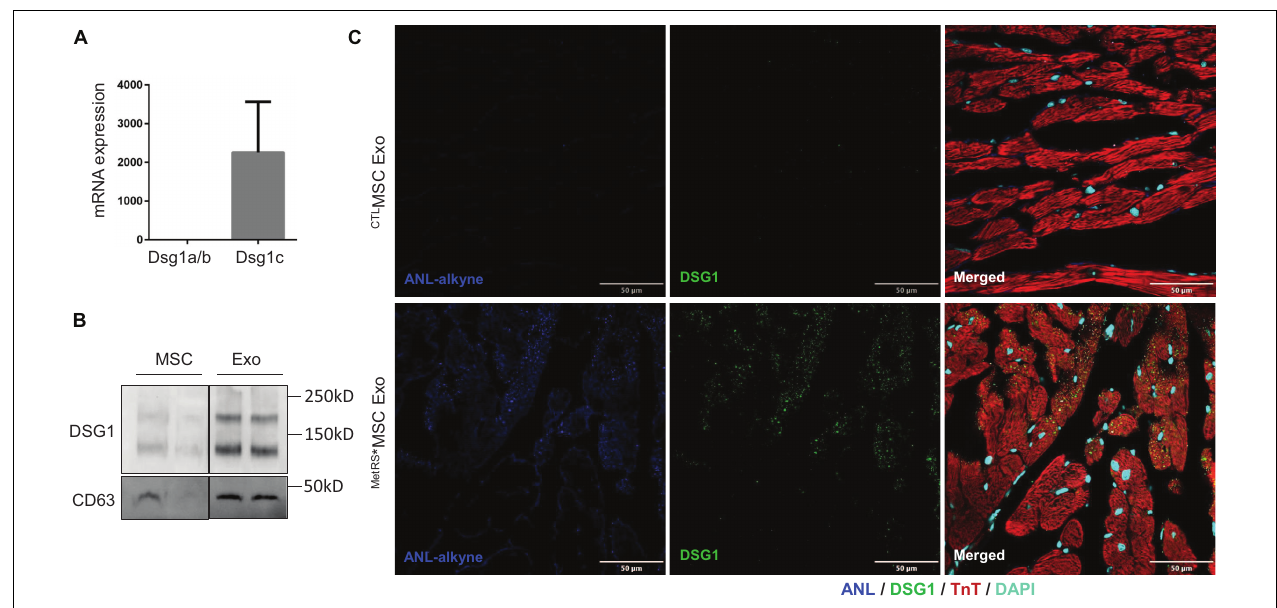
FIGURE 7 | MSC exosomes contain DSG1 and deliver DSG1 to the cardiomyocytes of infarcted hearts. (A) mRNA levels of Dsg1 isoforms a/b and c were evaluated in MSCs via qRT-PCR and normalized to GAPDH mRNA levels. (B) The abundance of DSG1 protein in MSCs and MSC exosomes was evaluated via Western blot. (C) MetRS ∗ MSC-Exos and CTL MSC-Exos were injected into the tail vein of mice 3 days after surgically induced MI. Mice were euthanized 4 h after exosome administration, and heart-tissue sections were click-stained to identify the ANL-labeled MetRS ∗ MSC exosomal proteins and immunofluorescently stained for the presence of DSG1 and troponin T (TnT) protein; nuclei were counterstained with DAPI.